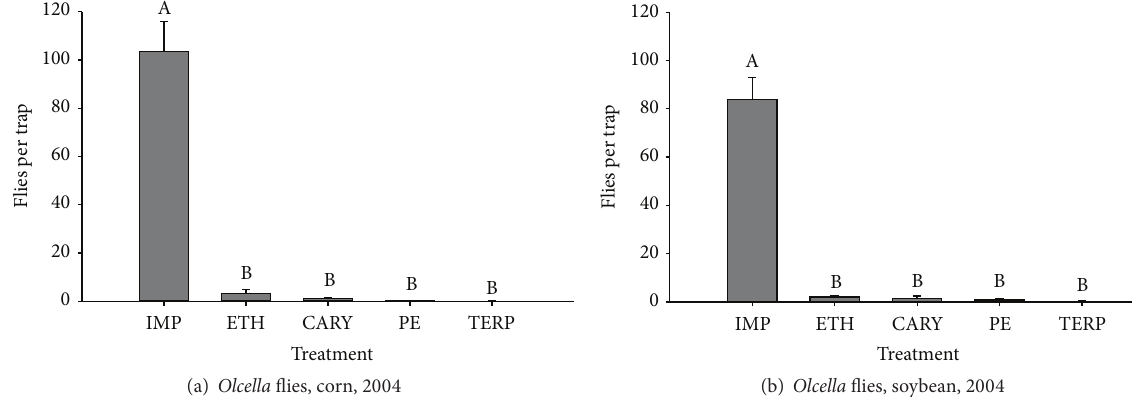
Figure 5: Mean number of adult Olcella sp. flies per sticky trap ( ± SE) baited with 100mg of volatile chemicals in plots near Brookings, SD. Chemicals dispensed on cotton rolls. Bars without the same letters above them indicate that the means differ significantly. (a) Aug 2–4, 2004, corn plot (test #1). (b) Aug 17–19, 2004, soybean (test #2). IMP = 2-isopropyl-3-methoxypyrazine, ETH = ethanol (control), CARY = trans -caryophyllene, PE = 2-phenylethanol, and TERP = terpineol. Zero counts for camphor (CAM) traps not